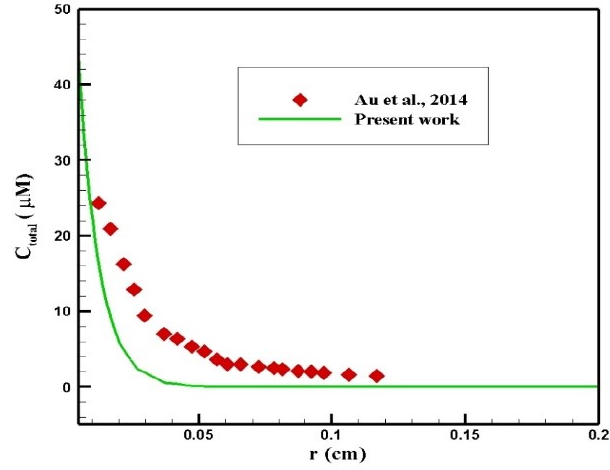
Figure 24. Comparison of the concentration values in terms of penetration depth at 6 h after injection with the values obtained from the study by Au et al. [50].